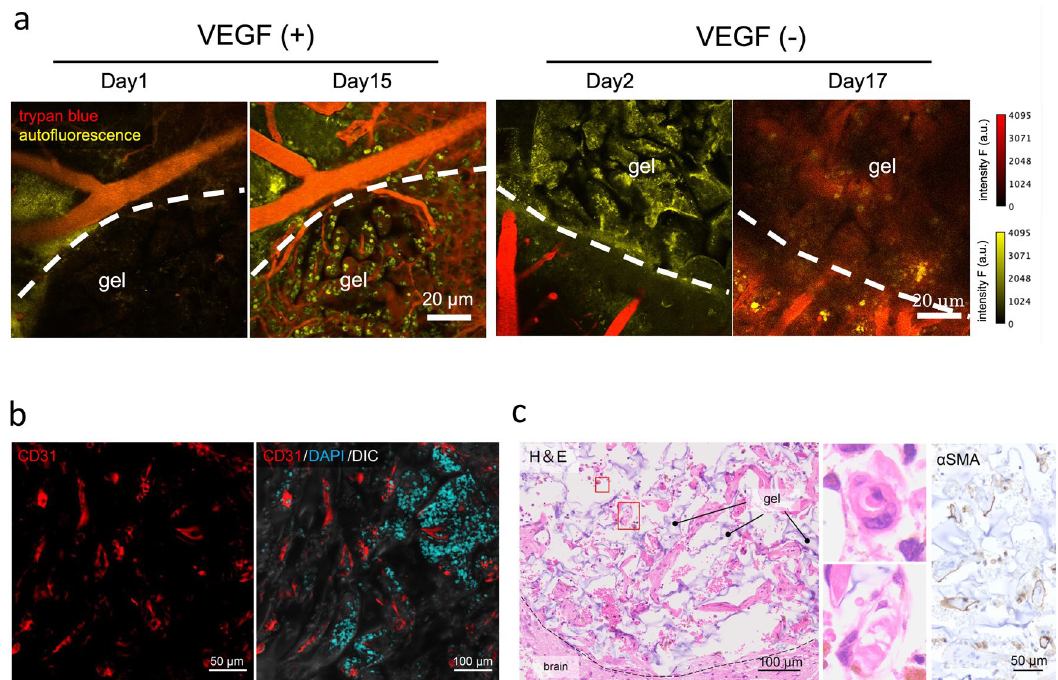
Figure 4. Vascular network formation in implanted VEGF-immersed C1A1 porous hydrogels. ( a ) In vivo live imaging of implanted C1A1 porous hydrogels by two-photon microscopy through a cranial window. C1A1 porous hydrogels were immersed in PBS with (left, n = 3) and without (right, n = 4) VEGF (50 ng/ml). In the VEGF ( +) group, blood vessel formation was confirmed in two out of three mice, but in the VEGF (-) group, no blood vessels were formed in any of the four mice. Trypan blue was injected into the mice through the ocular vein, and the boundary areas were observed at the indicated time points. The dotted lines are the boundary between the C1A1 porous hydrogel and the brain tissue. Red indicates trypan blue (vessels), and yellow indicates cells that produce autofluorescence, such as immune cells. ( b ) Immunostaining of the implanted C1A1 porous hydrogel for CD31 on day 21 (left) in combination with DAPI (right). ( c ) Histological analysis of the implanted C1A1 porous hydrogel on day 200 (left panel). Light purple indicates the hydrogel. Higher- magnification photographs of two areas in the left panel with blood vessels are displayed as two small panels in the middle. Immunostaining for αSMA is shown VEGF promotes vascularization in the C1A1 porous hydrogel.